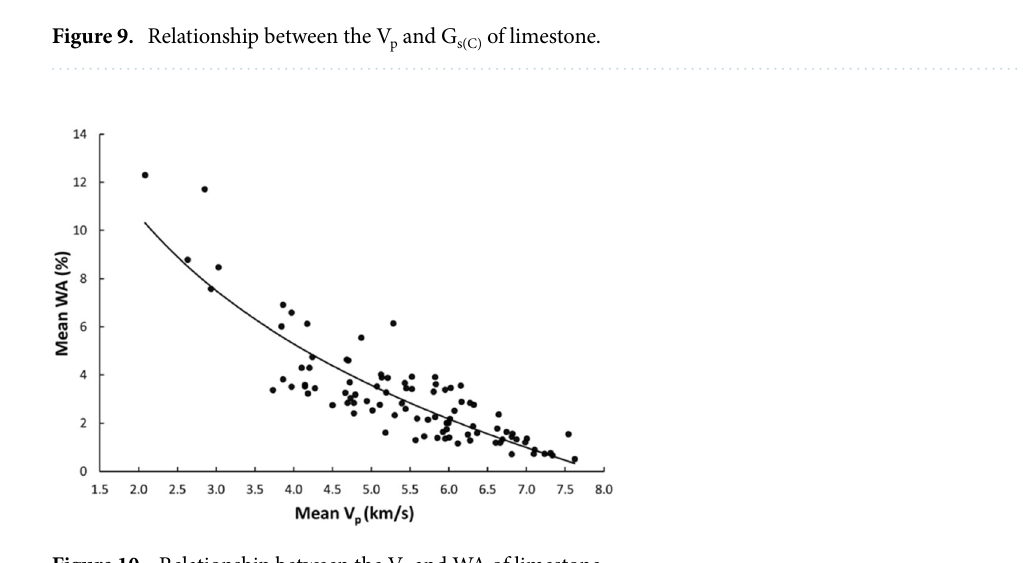
Figure 10. Relationship between the V p and WA of